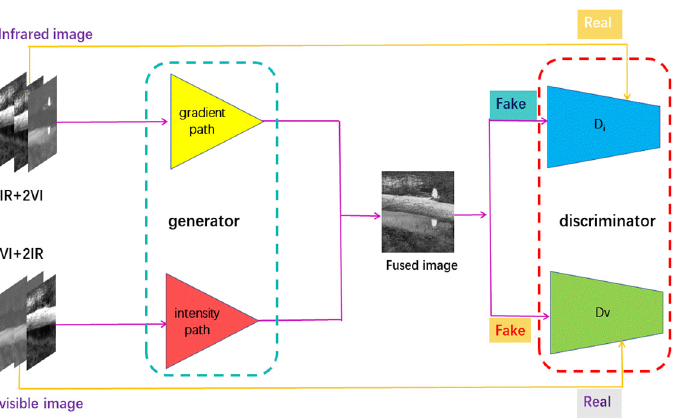
Figure 2. Overall fusion framework of our